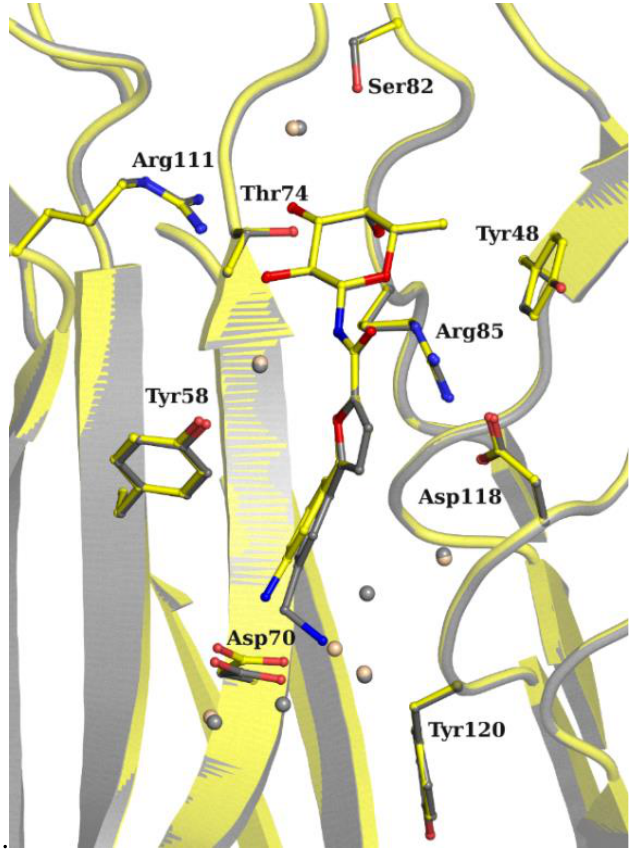
Figure 6. Overlay of the X-ray structure of the complexes of BC2L-C-Nt: with 2 (PDB 7OLW, yellow) and 3 (PDB 8BRO, grey).